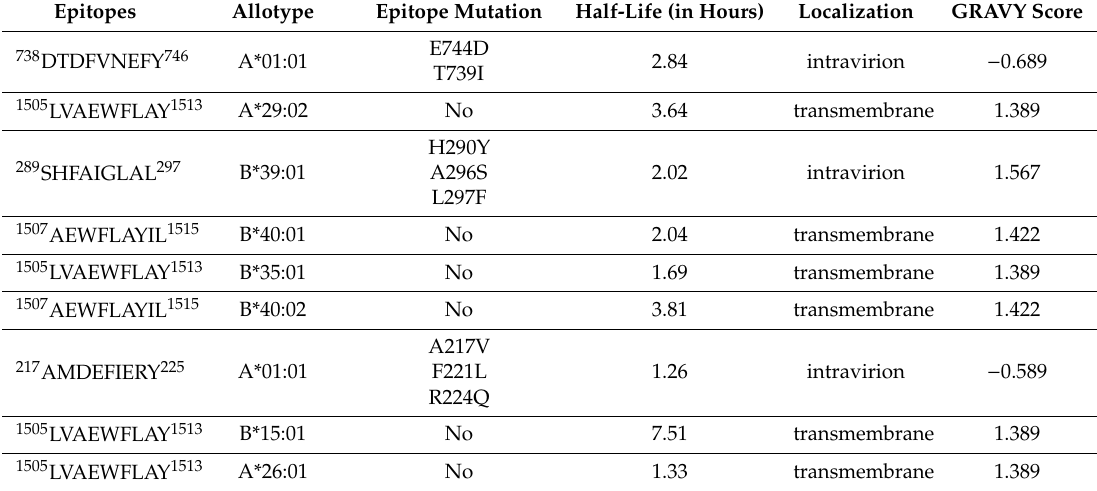
Table 5. Predicted half-lives of the novel SARS-CoV-2-derived, most immunogenic in-silico-identified epitopes in complex with the allotypes shown in Table 2. Secondary structures, localization within SARS-CoV-2, GRAVY scores and known mutations in the